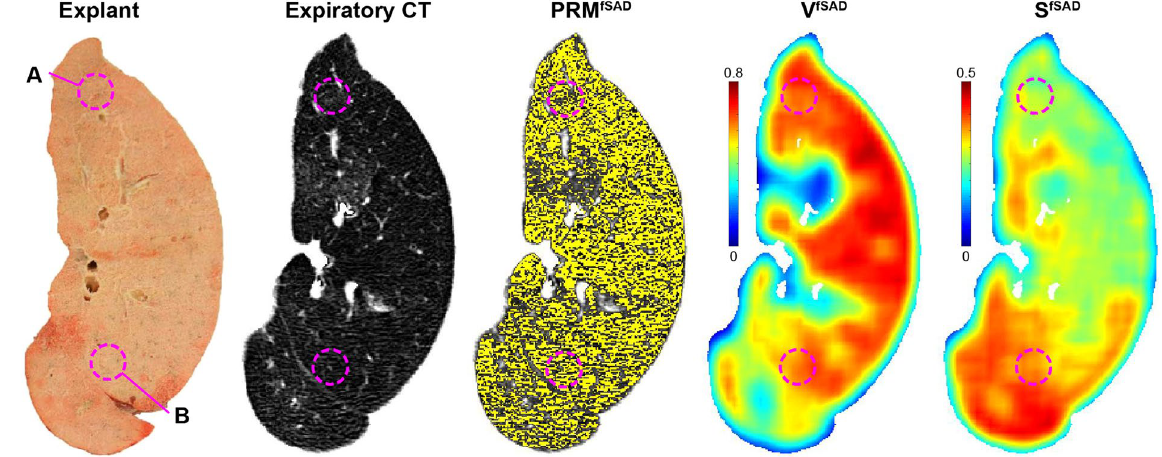
Figure 4. Confirmation of topological features altered by tissue microenvironment. An explanted lung from a single subject diagnosed with bronchiolitis obliterans syndrome was analyzed by microCT. Presented are the explanted lung section, expiratory CT scan, PRM fSAD , Local V fSAD and Local S fSAD . All CT derived images were spatially aligned to the lung section, allowing identification of core regions ( A , B ) on PRM and topological